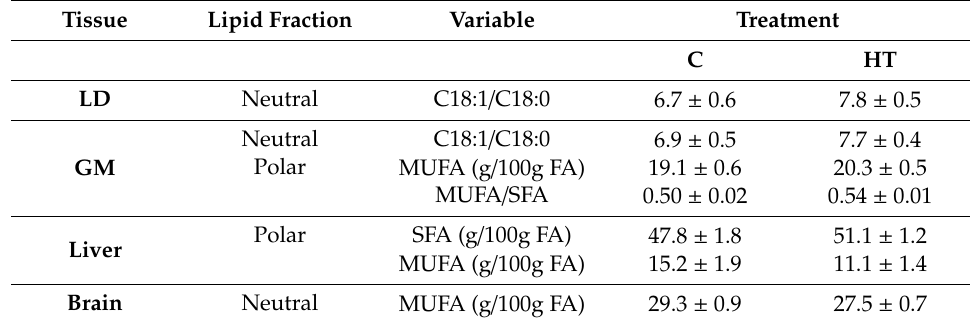
Table 4. Mean values ( ± S.E.M.) of the fatty acids composition of tissues in pigs born from sows treated or not with hydroxytyrosol (groups HT and C, respectively) at 25 days-old. All values are significantly di ff erent between treatments ( P <